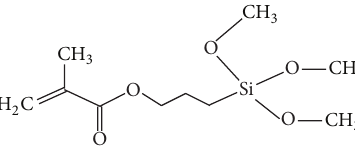
Figure 3: 3-Methacryloyloxypropyltrimethoxysilane silane-coupl- ing